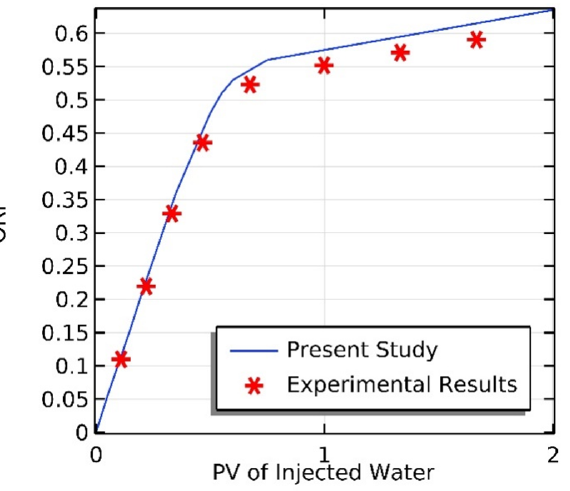
Figure 5. Comparison of numerical and experimental